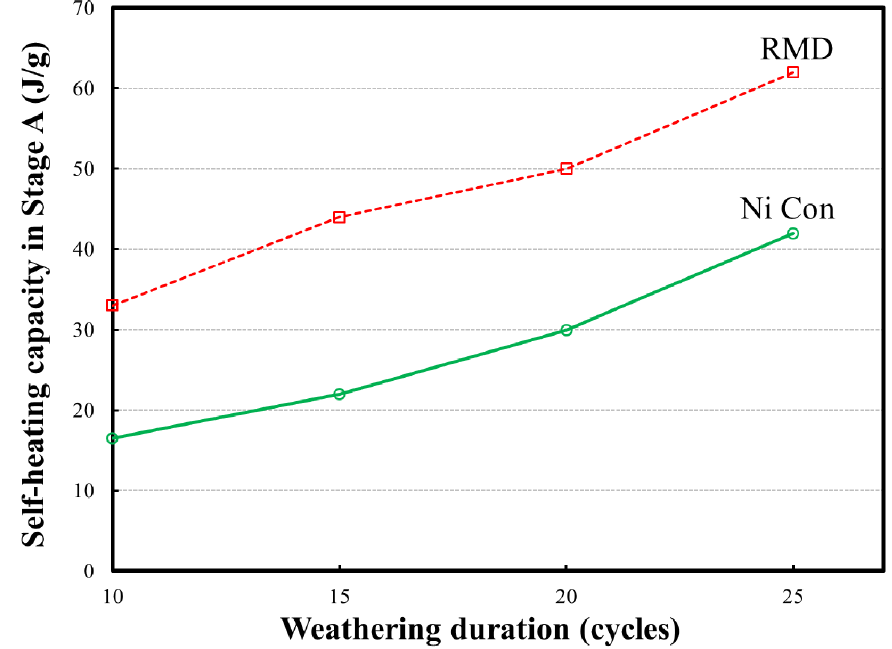
Figure 7. E ff ect of weathering on Stage A self-heating capacity (for calculation for self-heating capacity see [3]).